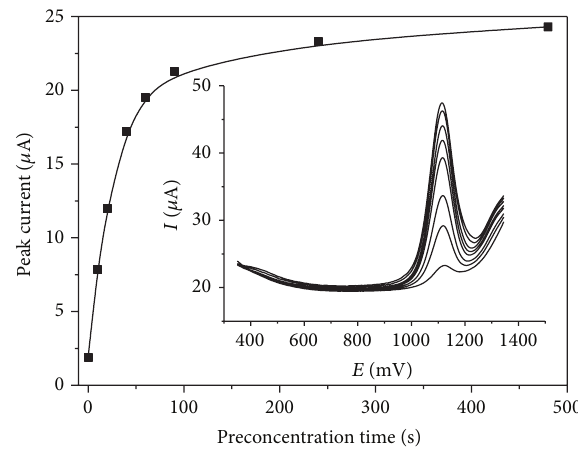
Figure6:Dependenceofthepeakcurrentonpreconcentrationtime in the range from 0 to 480s for 10 𝜇 M codeine in 0.1M phosphate buffer (pH 3.0) and volume of Nafion/MWCNTs 10 𝜇 L and obtained voltammograms. All other conditions are as in Figure 5.